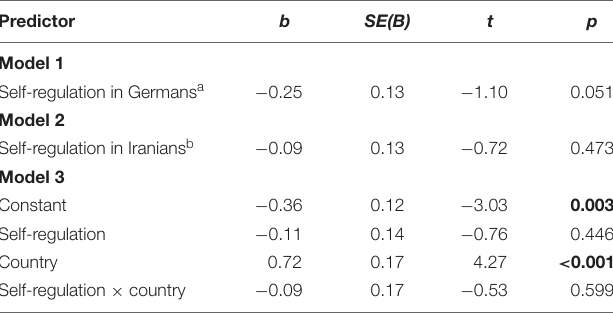
TABLE 2 | Regression analysis predicting multiplication RT from self-regulation in German and Iranian students.